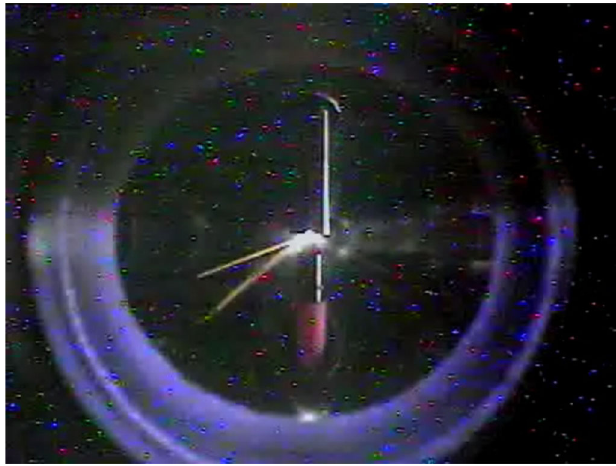
FIG. 5. (Color) Image of a discharge event. In this case, the spark is generated by applying a DC HVof (cid:2) 5 : 0 kV to the lower